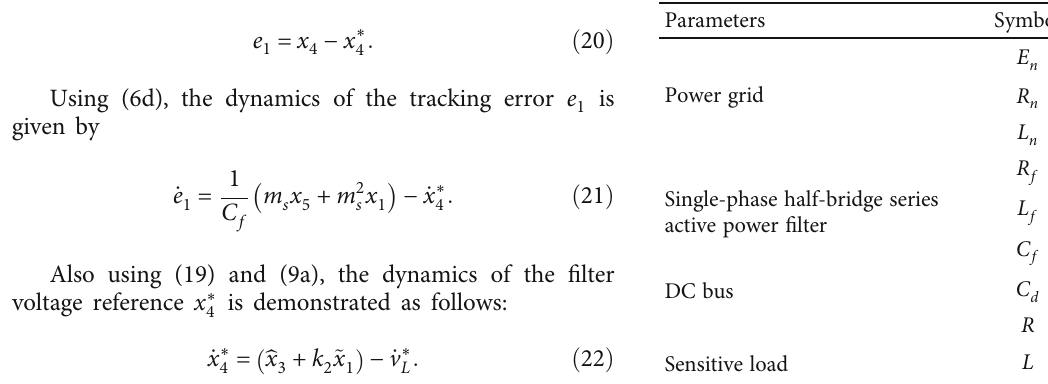
Table 2: Parameter system.